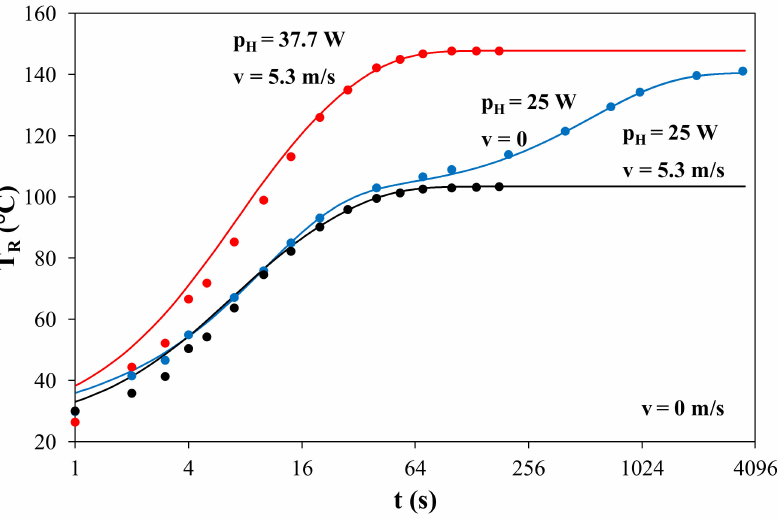
Figure 18. Measured and computed heating curves of the internal temperature of the resistor situated on the heat sink with a fan (system